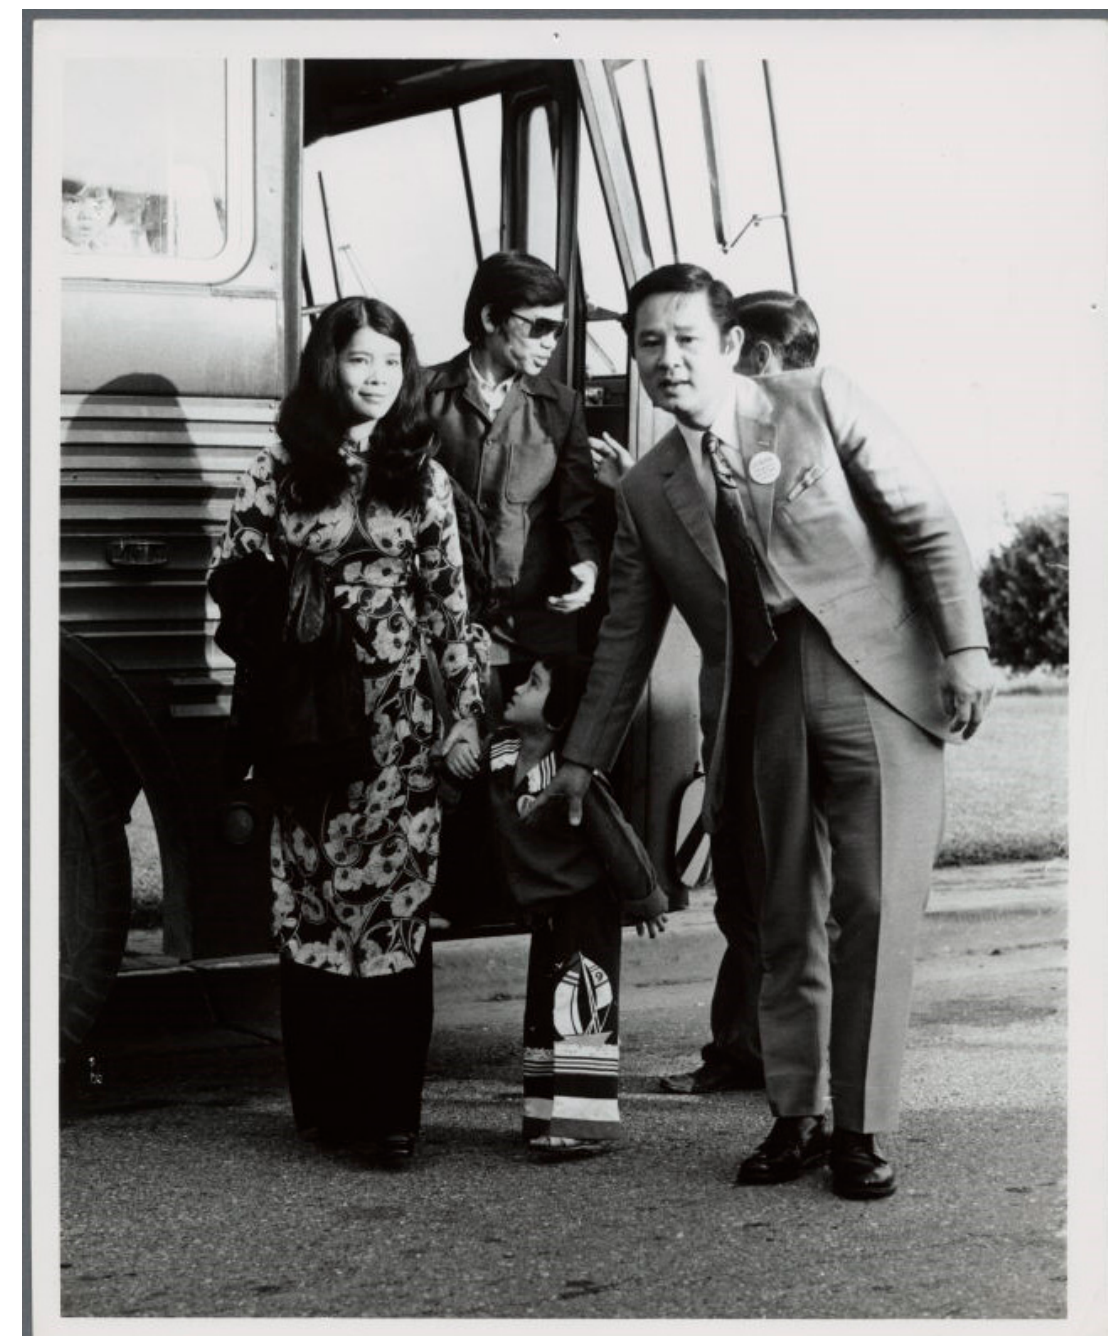
Figure 1. “Couple with child coming off a bus. Fort Chaffee